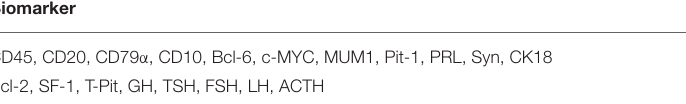
TABLE 2 | Immunohistochemistry results. Biomarker